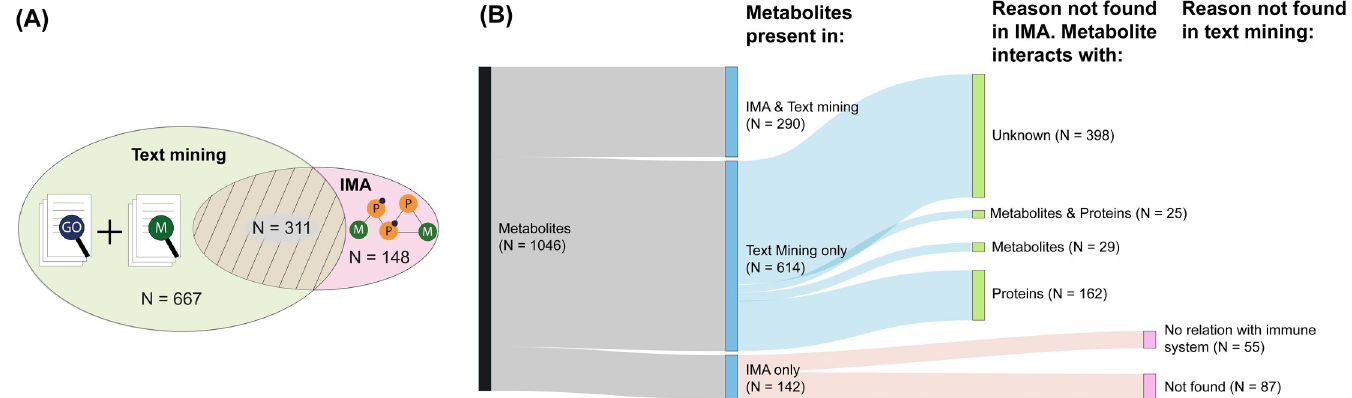
Fig 5. Comparison of metabolites in IMA database and text mining dataset for validation. (A) Text mining was used to identify co-occurrences of GO-terms and metabolites present in the IMA database. Metabolites obtained from co-occurrences were compared with associations found using IMA. (B) Sankey diagram of metabolites found in both IMA and text mining. 290 of 1 046 metabolites found are present in both IMA and text mining datasets. The portion of non-overlapping metabolites can be explained based on exclusion criteria for the atlas. 614 metabolites were only found in literature, of which 398 have no known interaction to any proteins or metabolites in the IMA. There were interactions found of the metabolites to other metabolites (n = 81), metabolites and proteins (42) or proteins (160), but these did not have an association to an immune process in the IMA database. Of the 142 metabolites that were only found in the atlas, 87 could not be found in literature and 55 were found in literature but missed any connection to an immune process.